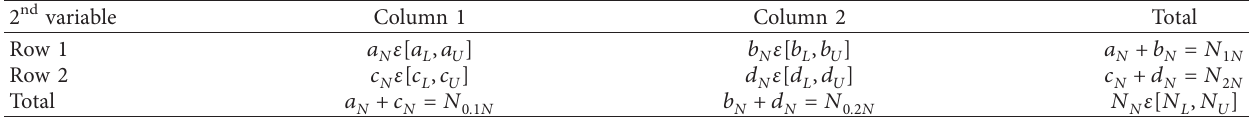
Table 1: 2 × 2 contingency table 1 st variable.